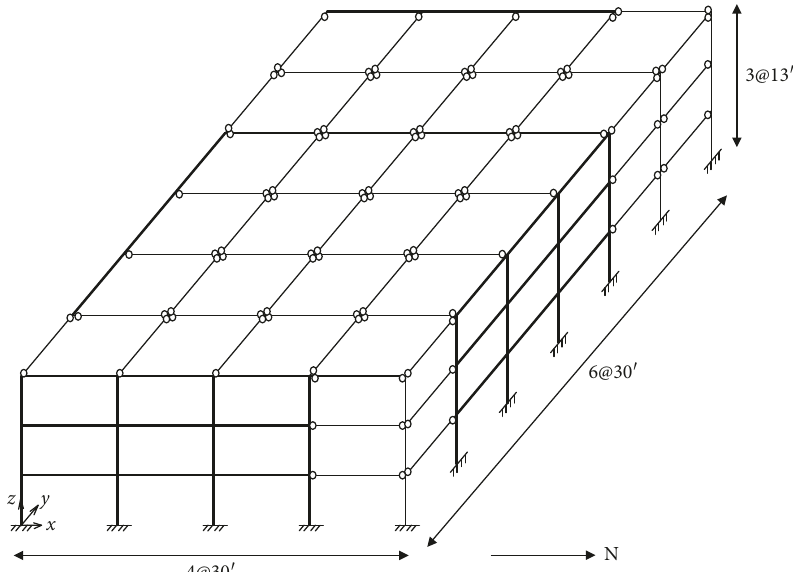
Figure 1: Isometric view of the 3-level building.